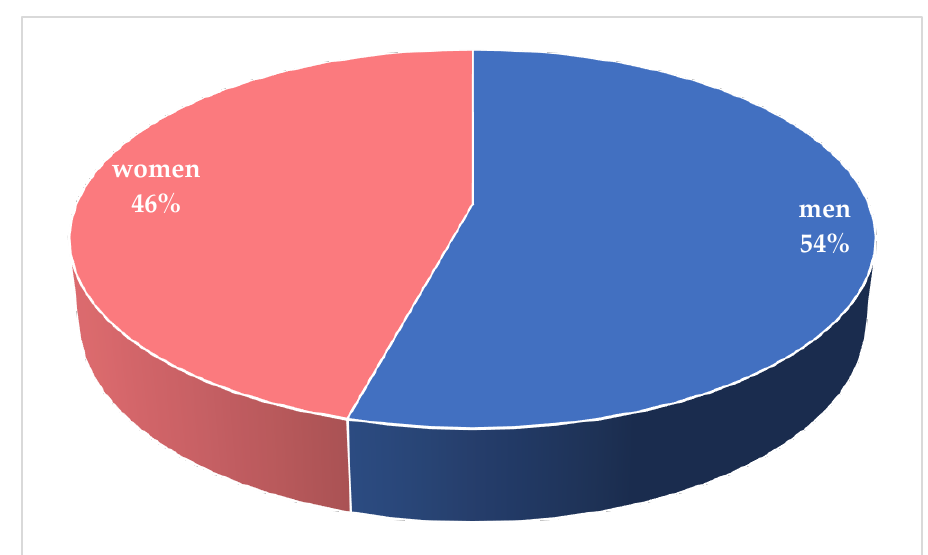
Figure 4. Distribution of cases according sex. The main risk groups were healthcare workers and patients with comorbidities. In total, 66/260 cases (2.3%) occurred among high risk groups, including healthcare workers (HCWs), doctors, students and nursing resident. A total of 91 cases (35%) occurred among patients with comorbidities, 48 in men and 38 in woman (Figure 5).